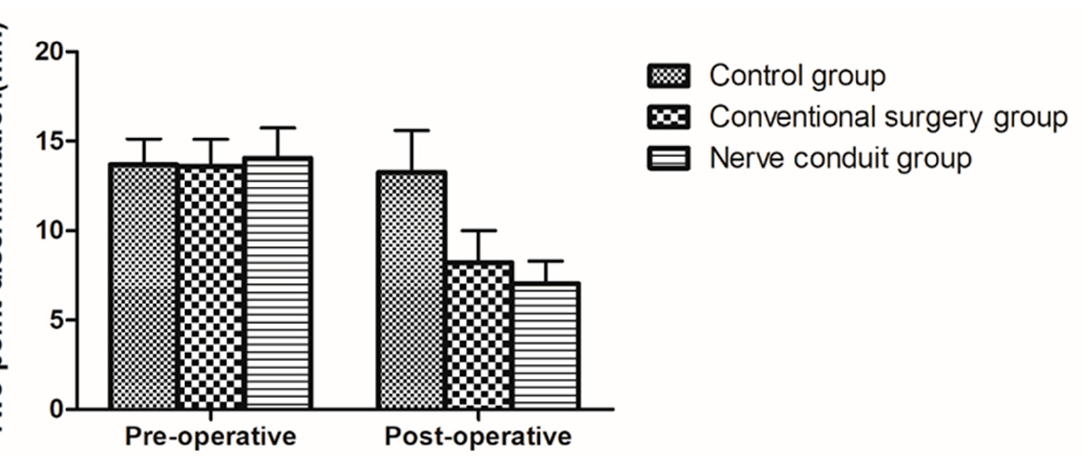
Table 6. Results of the 2-PD test in the three groups. Nerve Conduit Group